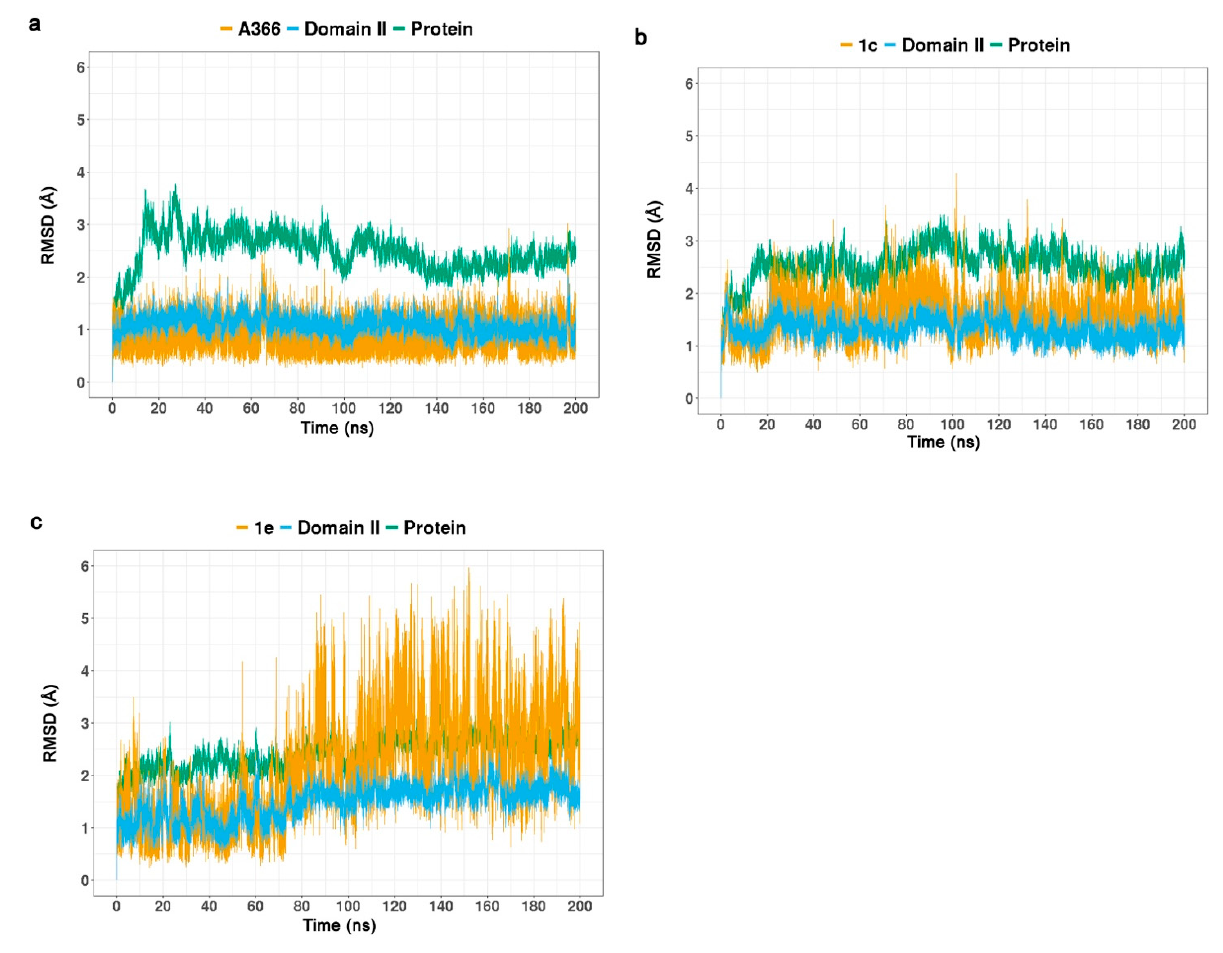
Figure 4. Analysis of 200 ns MD simulations of reference ligand A366 and inactive compounds 1c and 1e . Root mean square deviation (RMSD) plots of the systems with ( a ) A366 , ( b ) 1c , and ( c ) 1e .